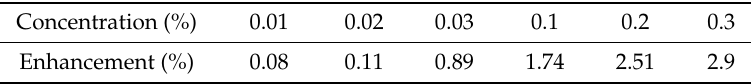
Figure 1. Viscosity of nanofluid and base fluid at different volume concentrations [47]. Table 3. Enhancement in the effective viscosities of Al 2 O 3 nanofluids at various nanoparticle concentrations at 21 °C [48].